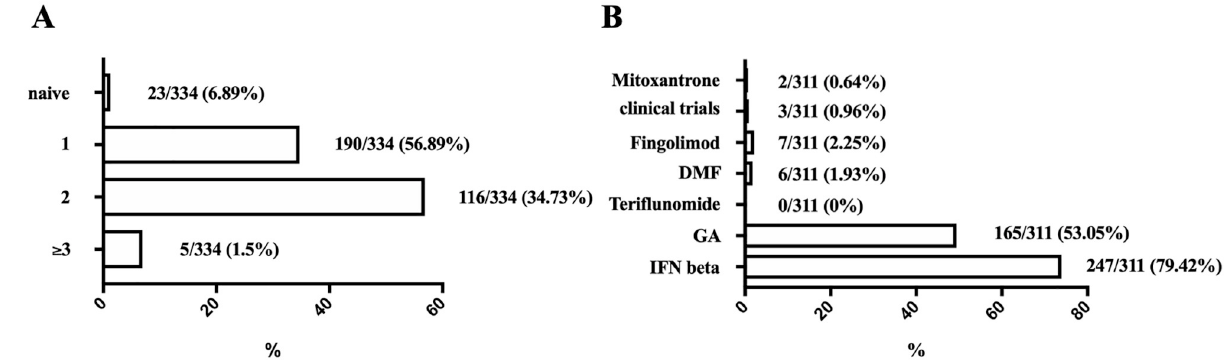
Fig 1. Characteristics of the previous therapy. A—number of previous DMTs; B—profile of previous DMT before NTZ initiation (n = 311, excluding treatment-na ï ve patients). DMF—dimethyl fumarate; GA—glatiramer acetate; IFN beta—interferon beta.